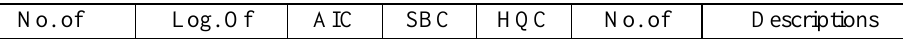
Table 9: Diagnostic statistics for two estimates of the model (authors’ calculations) No. of Log. Of AIC SBC HQC No.